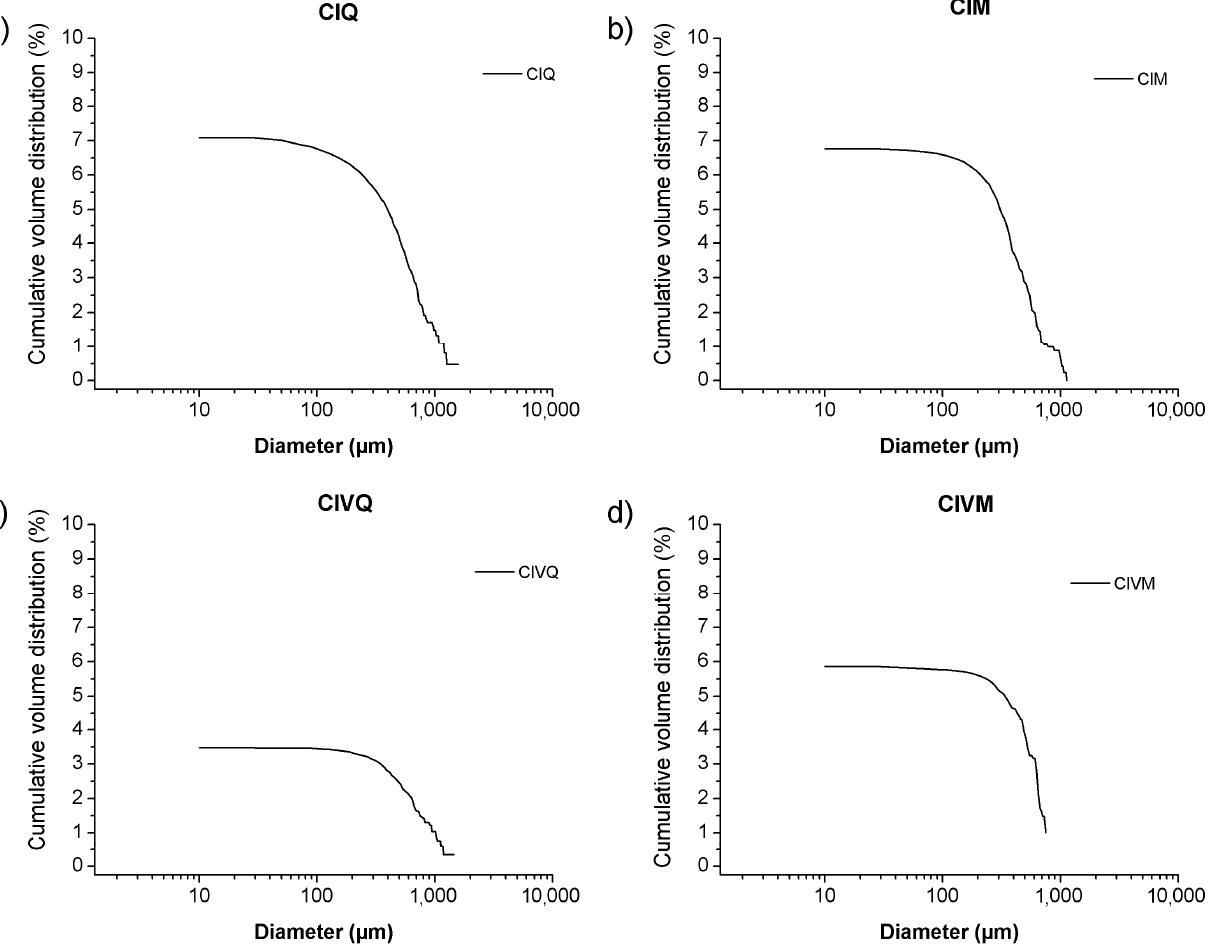
Figure 8. Cumulative porosity distribution of samples: ( a ) CIQ ( b ) CIM ( c ) CIVQ and ( d ) CIVM analyzed with computed X-ray tomography.